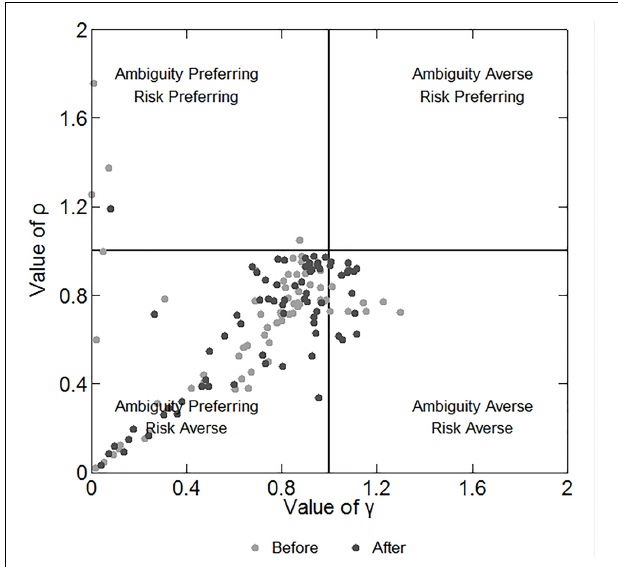
FIGURE 4 | Estimated parameters and the corresponding preferences of participants before and after the stimulations. The X -axis depicts the degree of ambiguity aversion and the Y -axis depicts the degree of risk aversion.